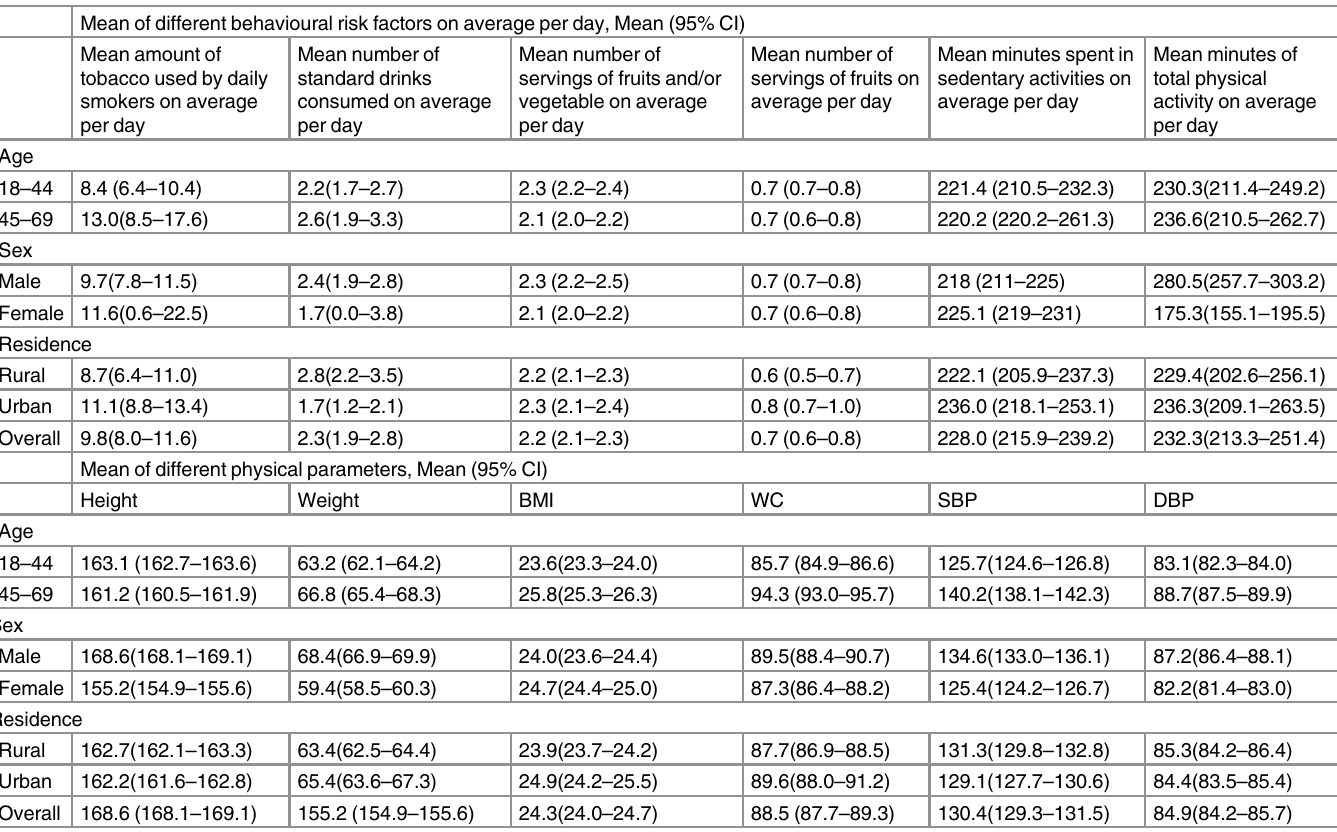
Table 3. Means (confidence intervals) of different parameters for behavioural information and physical measurements in population of Punjab State, 2014 – 2015. Mean of different behavioural risk factors on average per day, Mean (95% CI) Mean amount of tobacco used by